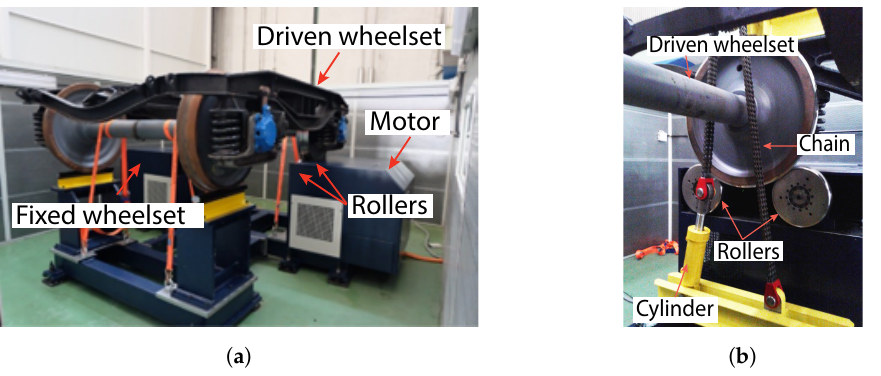
Figure 6. The test rig showing ( a ) bogie Y21 Cse set on the rig (without loading system) and ( b ) driven wheelset supported on the rollers and loading system with hydraulic cylinder and chain.